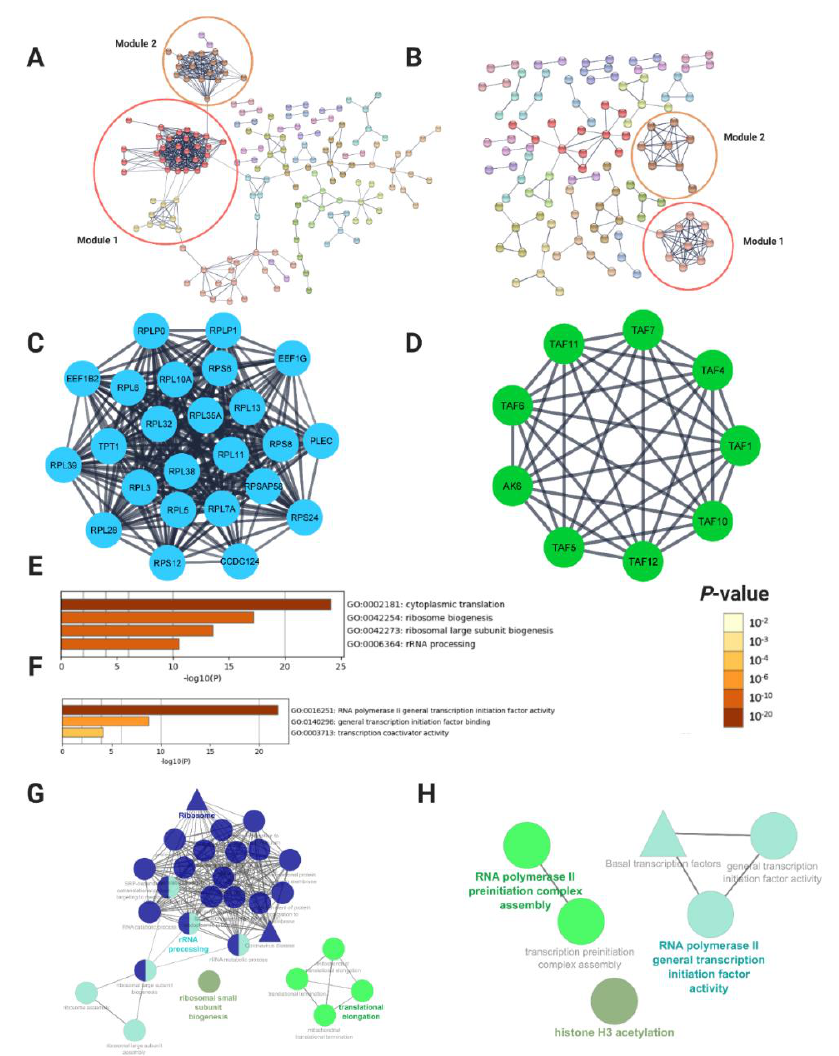
Figure 3. PPI network analysis of total DEGs converge to two main affected pathways in both, SOD1- and TDP43-ALS. ( A ) PPI network of SOD1- and ( B ) TDP43-ALS DEGs, in which thicker lines indicates stronger data support. The nodes indicate the DEGs and the edges indicate the interaction (experimental evidence only) between two proteins. The STRING database was used to establish functional associations among the known and predicted proteins using annotated DEGs as query for SOD1- and TDP43-ALS interaction networks, with high confidence score of >0.7 and a maximum number of interactions to top 20. ( C ) The module 1 from SOD1- and ( D ) TDP43-ALS identified from the whole PPI network. ( E ) Enrichment analysis of the module 1 from SOD1- and ( F ) TDP43-ALS by Metascape. X-axis represents the statistical significance of the enrichment ( − log10 ( p -value)). Bar chart of GO and Pathway terms colored by p -values were adapted from Metascape, where terms containing more genes tend to have more significant p -values. The length of the bar represents the significance of that specific gene-set or term. The brighter the color, the more significant that term is ( G ) Comprehensive enrichment analysis of the functional group network (only significantly enriched GO terms/Pathways are visualized, p -value ≤ 0.05) for module 1 in SOD1- and ( H ) TDP43-ALS using ClueGo/CluePedia plugin in Cytoscape. ClueGO/CluePedia annotation results are based on biological process (circular node) and KEGG pathway (triangle shape)